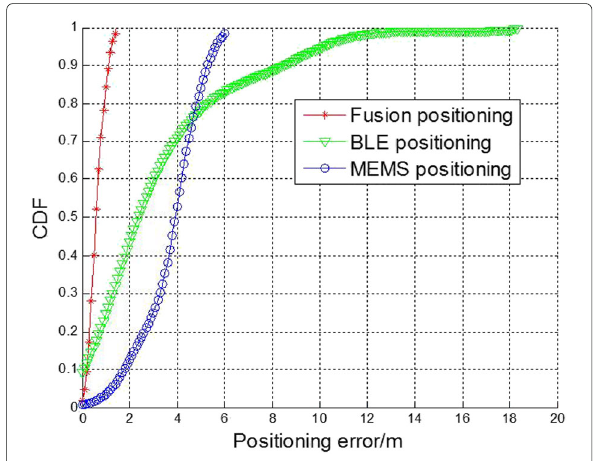
Fig. 29 Positioning error at each test point